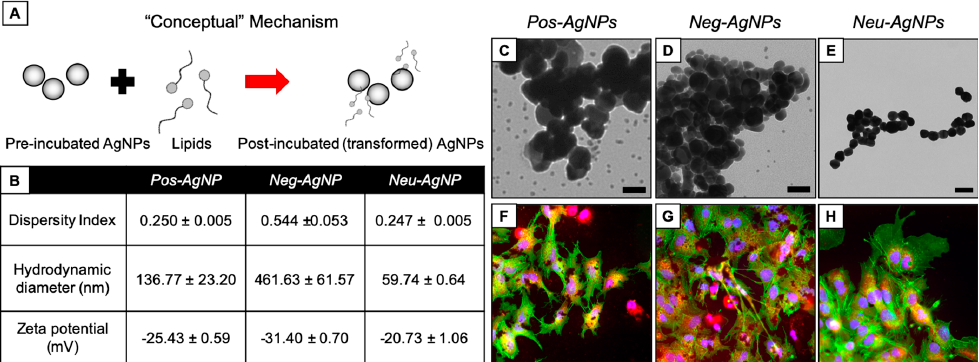
Figure 5. AgNP transformation after incubation in lipids. ( A ) Conceptual model of transformation mechanisms. ( B ) Dispersity index (unitless), hydrodynamic diameter (nm), and zeta potential (mV)